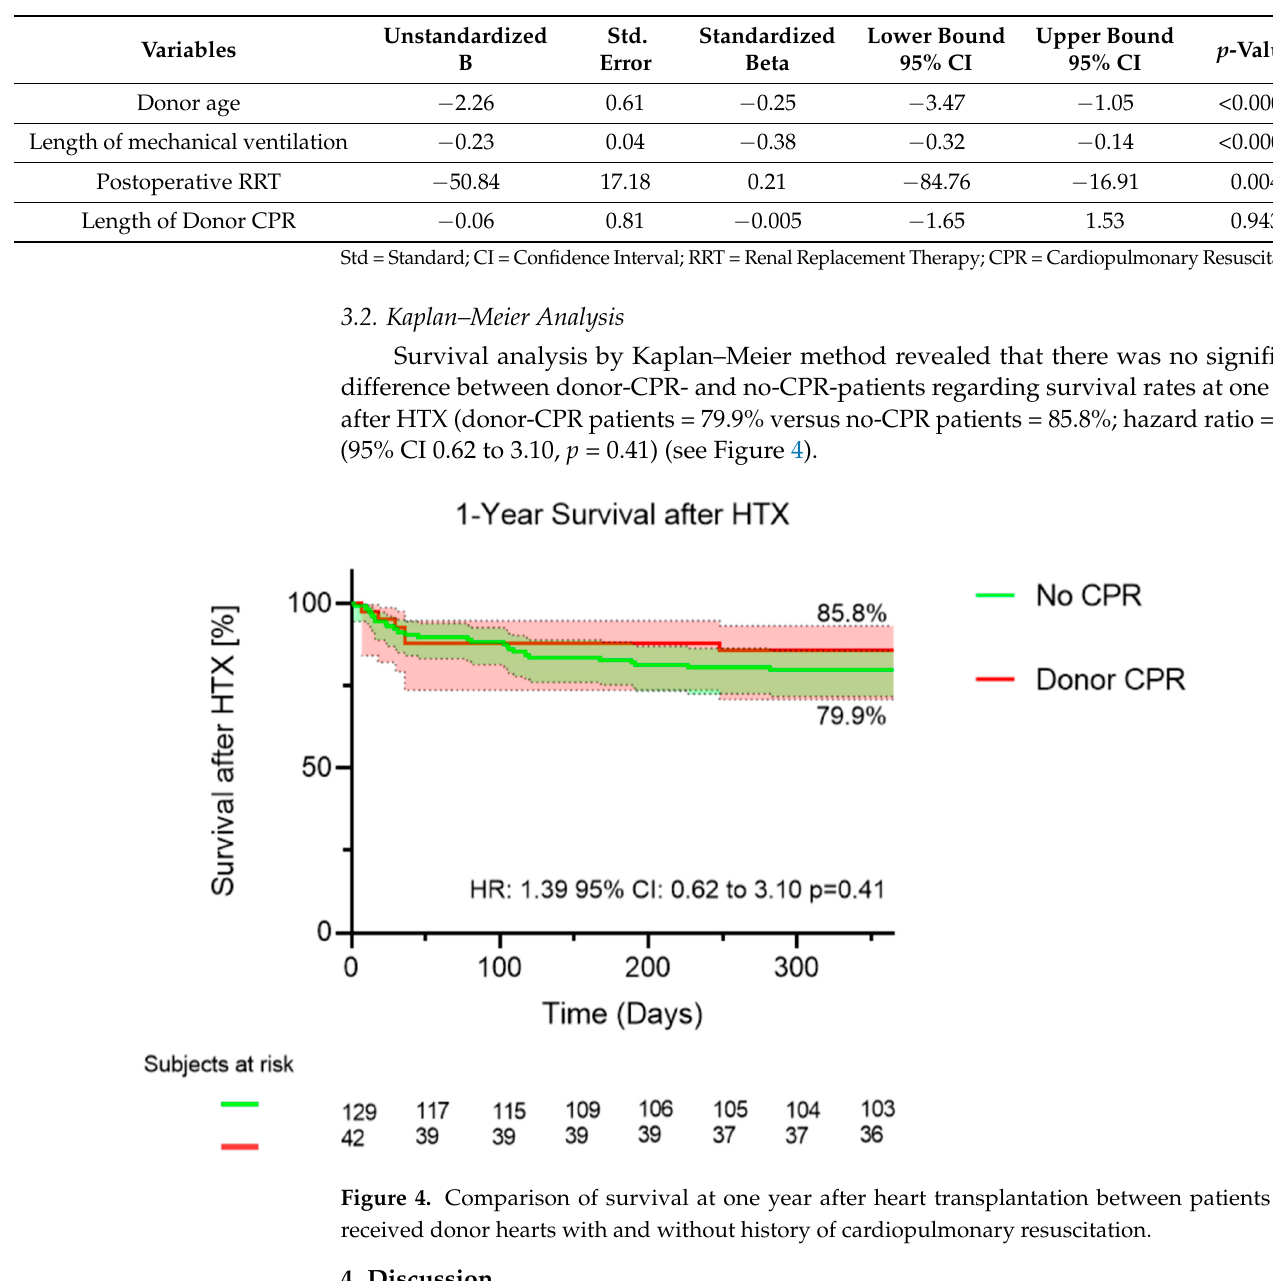
Table 2. Multivariate linear regression for the association between length of donor-CPR and DAOH at one year after heart transplantation.